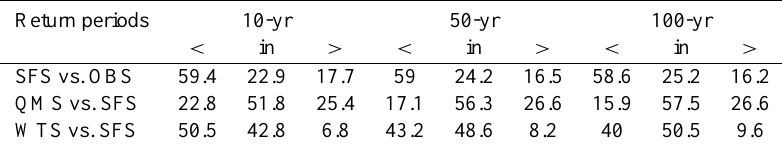
Fig. 2. Return levels of QMS and WTS against SFS, for a ten-year return level on a log-log scale. The error bars correspond to the 95% confidence interval for the SFS return levels. Table 3. Number of stations with a return level below ( < ), in the 95% confidence interval (in), or above ( > ), for different return periods and different simulations compared to references (OBS is the reference for SFS, SFS is the reference for QMS and